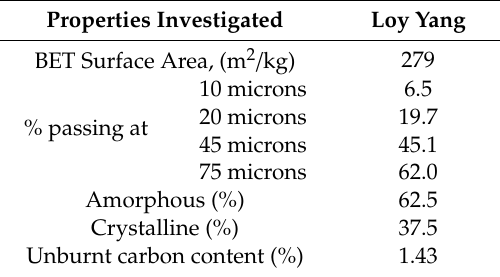
Table 2. The physical and mineralogical